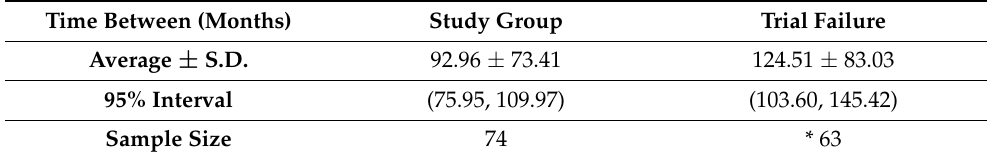
Table 8. Time duration of DOI to trial